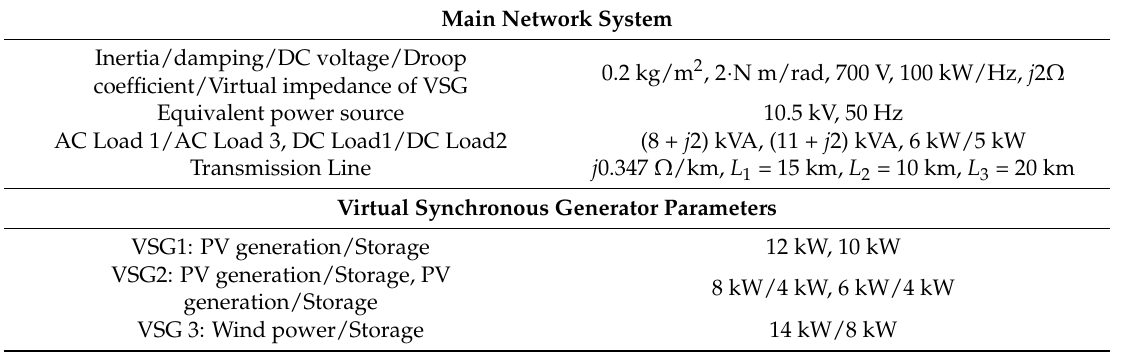
Figure 6. The semi-physical platform of the microgrid based on the RTDS system. Table 2. Case 2: Main simulation parameters of the microgrid system.